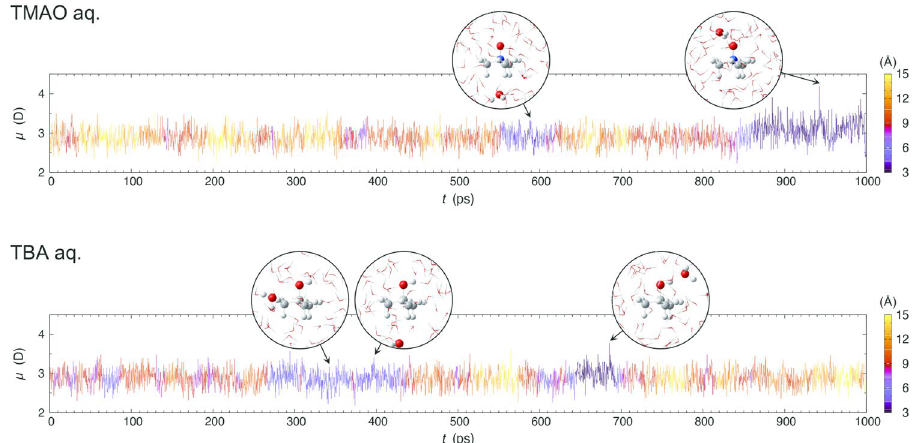
Figure 2. Temporal evolution examples of water dipole moments along 1 ns EFP-MD. The plot color represents the distances (N TMAO –O water /C TBA –O water ) as indicated by the key on the right.